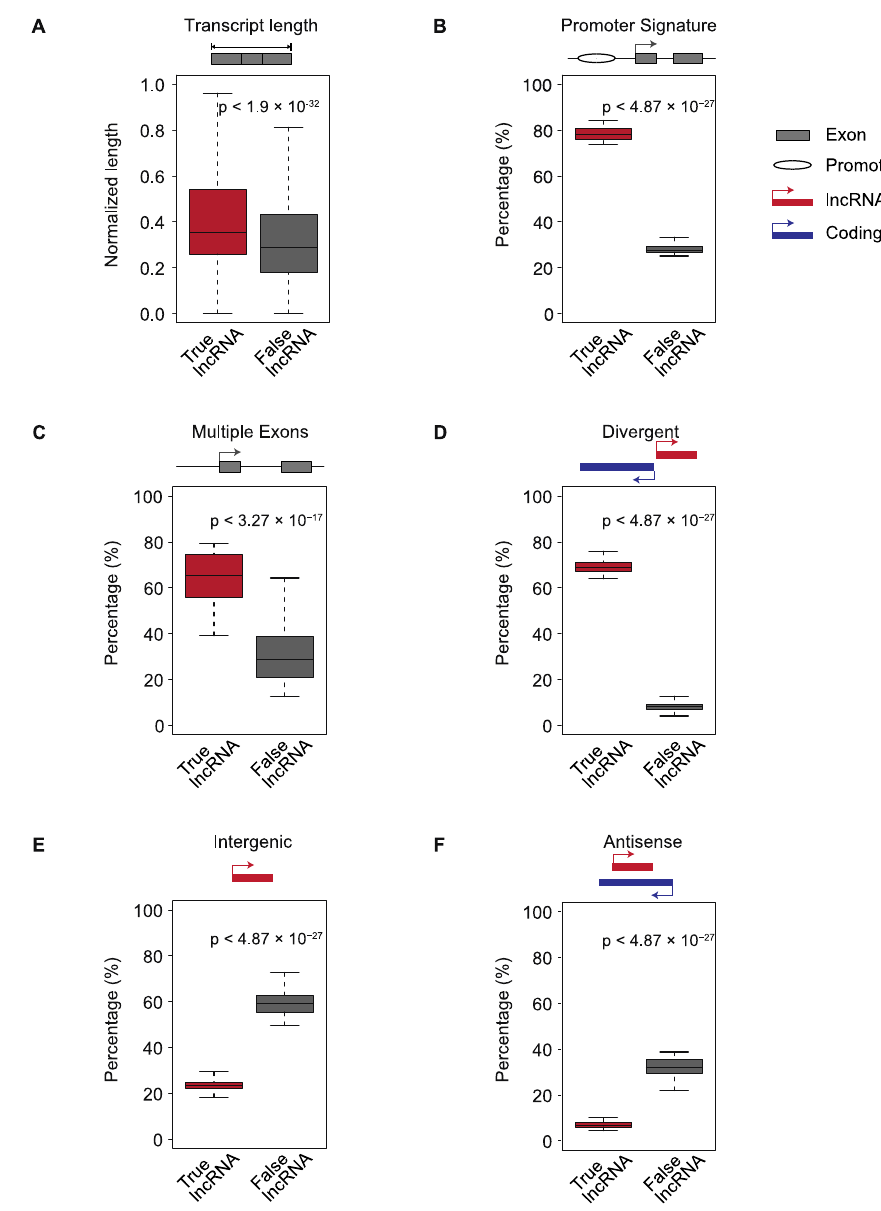
Figure 2. Four features exhibit significant differences between true and false lncRNAs in the 46 benchmark datasets. True lncRNAs can be distinguished from false lncRNAs because they tend to be longer ( A ), to have a predicted upstream promoter signature ( B ), and to be more likely to have multiple exons ( C ). They can also be distinguished by genomic location and are more likely to be divergently transcribed from the promoter of a protein-coding gene ( D ). True lncRNAs are less likely to be in intergenic regions ( E ) or antisense ( F ) to a protein-coding gene. For the graph ( A ), the boxplot represents the scaled transcript lengths of true and false lncRNAs. For the graphs ( B – F ), each boxplot represents the percentage of a feature of true and false lncRNAs among the identified putative lncRNAs for each of the 46 benchmark datasets. The p -values were calculated by a two-sided Wilcoxon–Mann–Whitney test.